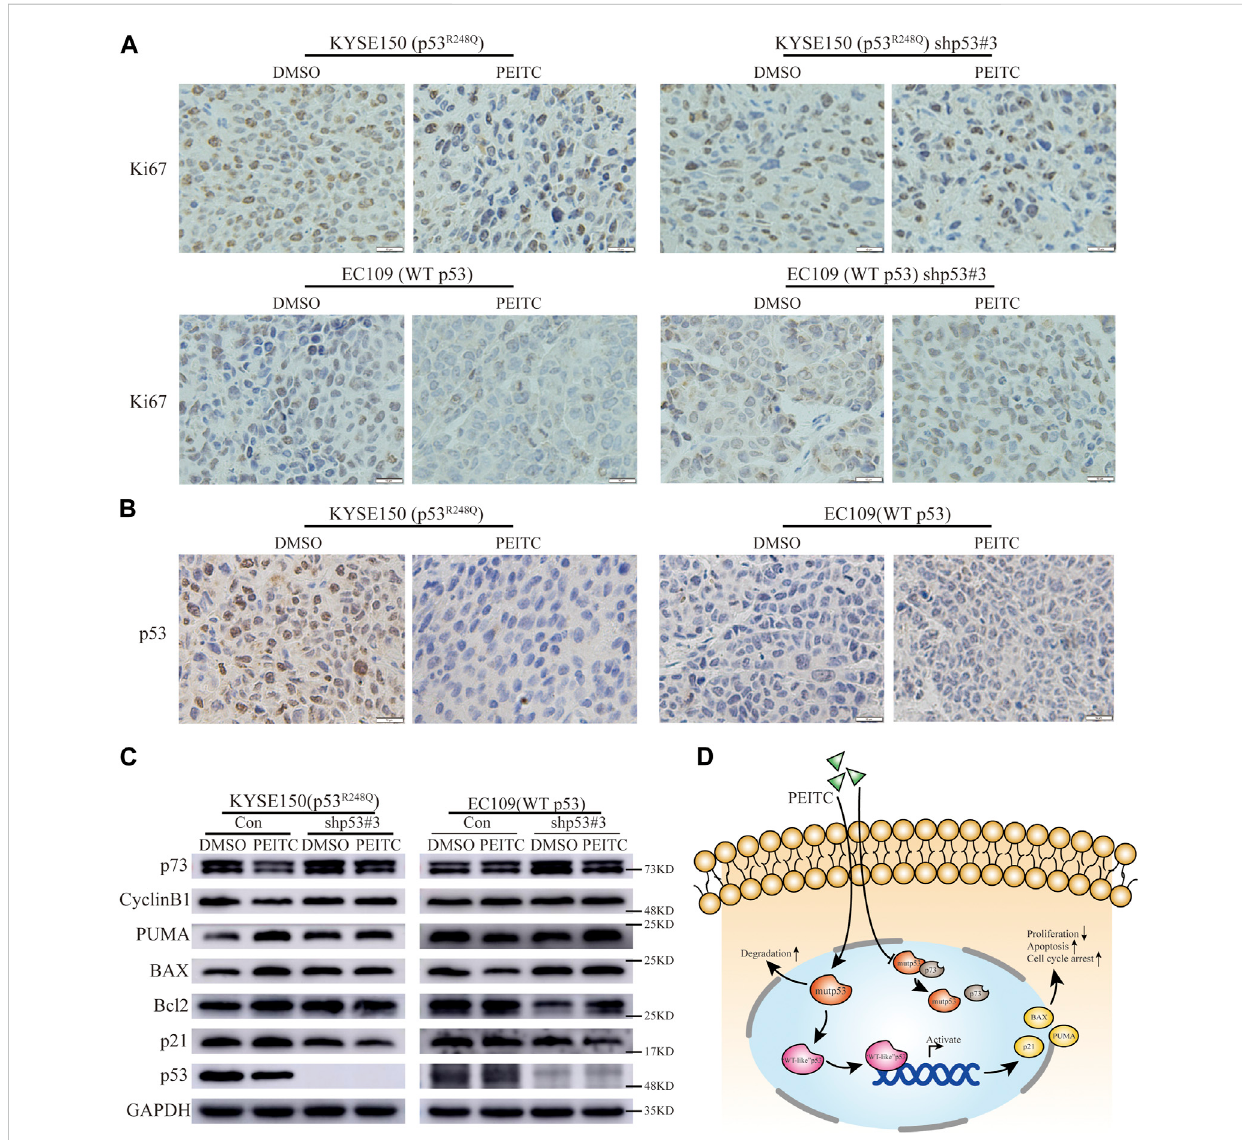
FIGURE 6 PEITC reactivates p53 R248Q in vivo . (A) IHC images of Ki67 (Scale bar = 10 μ m). (B) IHC images of p53 (Scale bar = 10 μ m). (C) Western blot showing p53, p21, Bcl2, BAX, PUMA, CyclinB1, p73 and GAPDH protein expression in tumor tissues. (D) Possible mechanisms of action of PEITC in p53 mutant